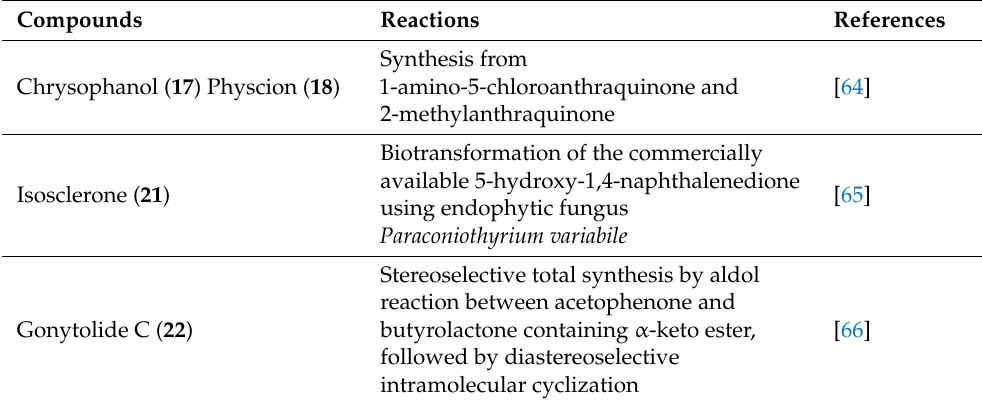
Table 1. Synthesis of some secondary metabolites produced by fungi of the genus Cytospora .